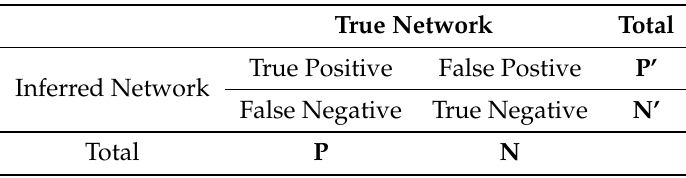
Table 1. Confusion